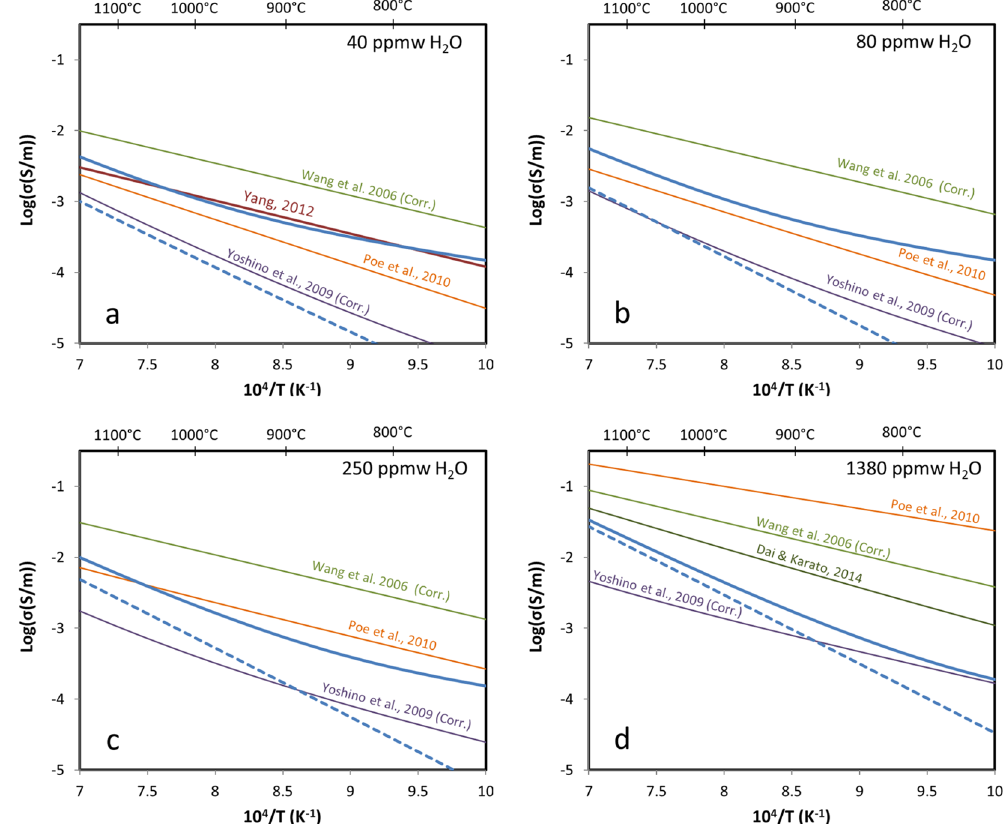
Figure 5. Electrical conductivity of hydrous olivine as a function of inverse temperature. Total electrical conductivity for hydrous olivine are calculated in this study using data for dry olivine (equations 4 and 5) from single crystal samples 36 (blue solid line) or polycrystalline samples 41 (blue dashed line). Total electrical conductivity from different studies in the literature 15, 23–26 is also displayed. Panels (a), (b), (c) and (d)